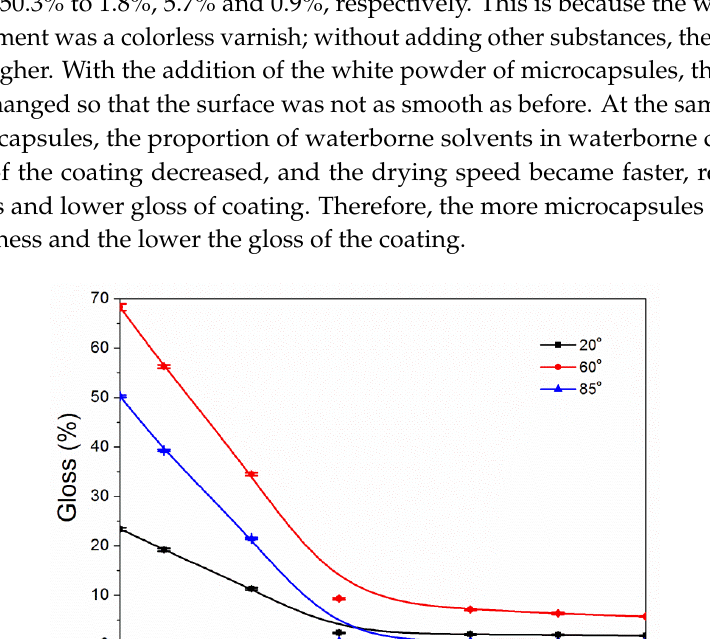
Figure 3. Infrared spectrogram of microcapsules.